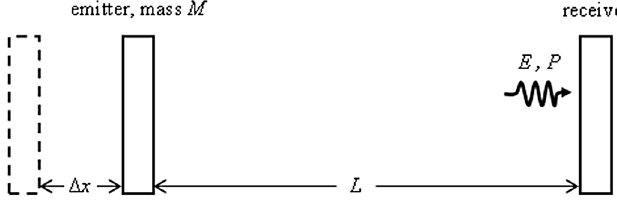
Fig. 1. Photon with energy E , linear momentum P , propagates from emitter to receiver and emitter recoils to the